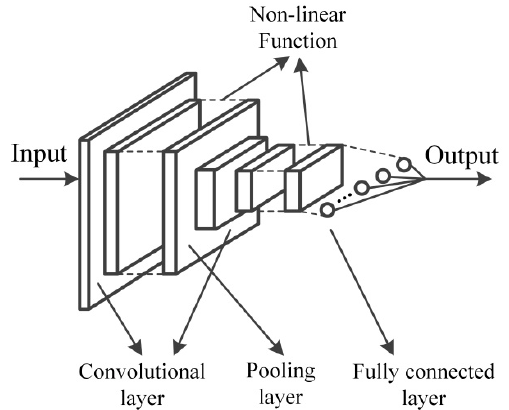
Figure 3. Convolutional neural network model structure.